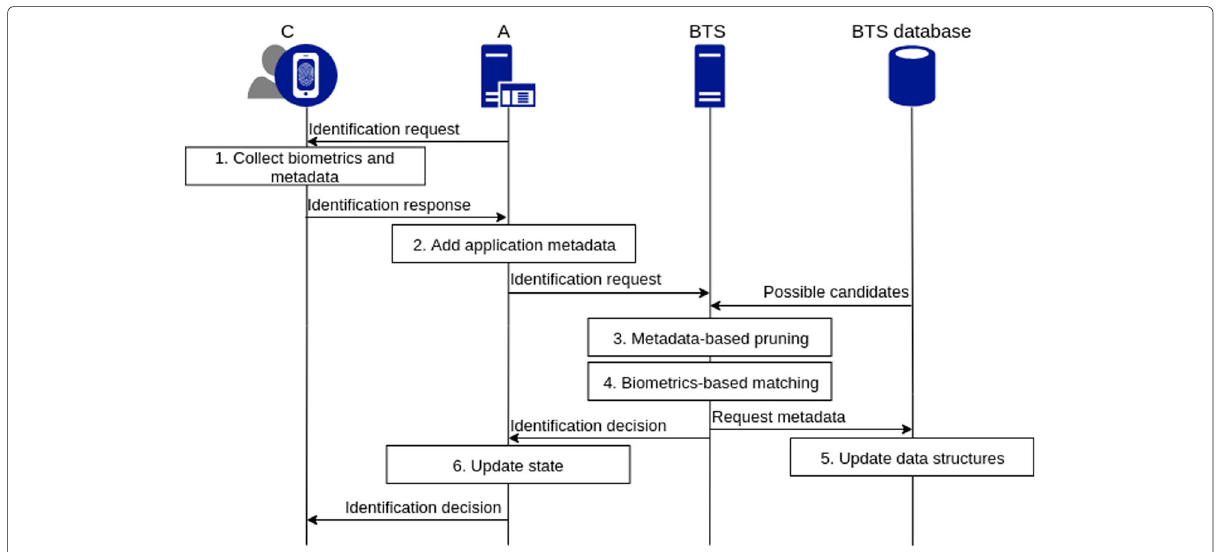
Fig. 2 Illustration of the identification